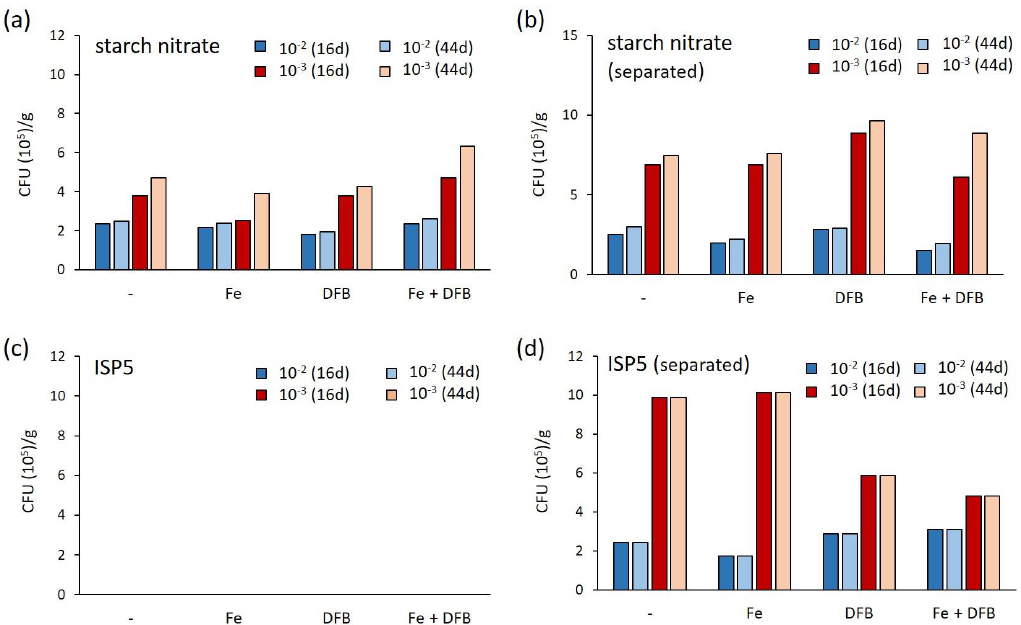
Figure 1. Total number of colony forming units (CFUs) according to the different media and methods used. The different media were inoculated with a diluted moonmilk suspension (10 − 2 in blue and 10 − 3 in red) prepared according to the rehydration-centrifugation method and incubated for up to two months. Data obtained after 16 days (16 d) and 44 days (44 d) of incubation are displayed. The “separated” label indicates that the autoclaving of agar and phosphate was performed separately from the other components of the media. Abbreviations: Fe, 20 µ M of FeCl 3 ; DFB, 1 µ M of desferrioxamine B.